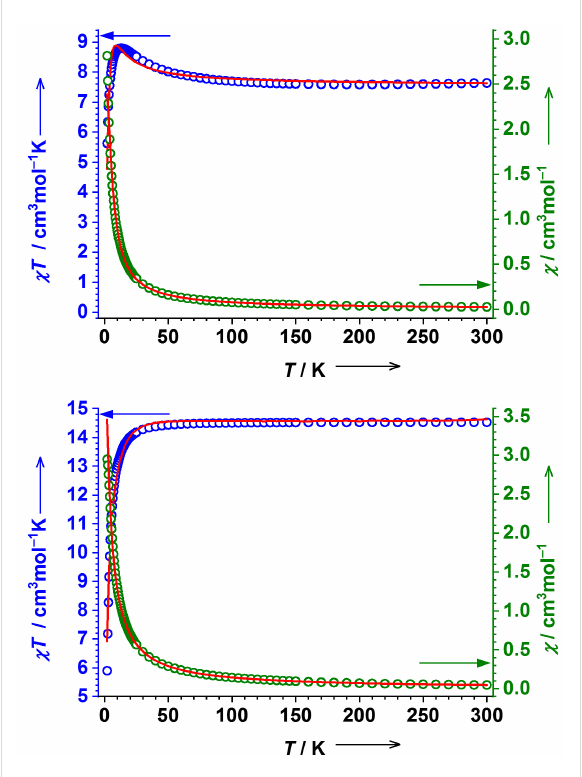
Figure 4: Variable temperature χ T product (blue) and χ (green) of 8 (top) and 9 (bottom) measured at an external magnetic field of 1 T in the heating mode (see Supporting Information File 1 for fitting parame-